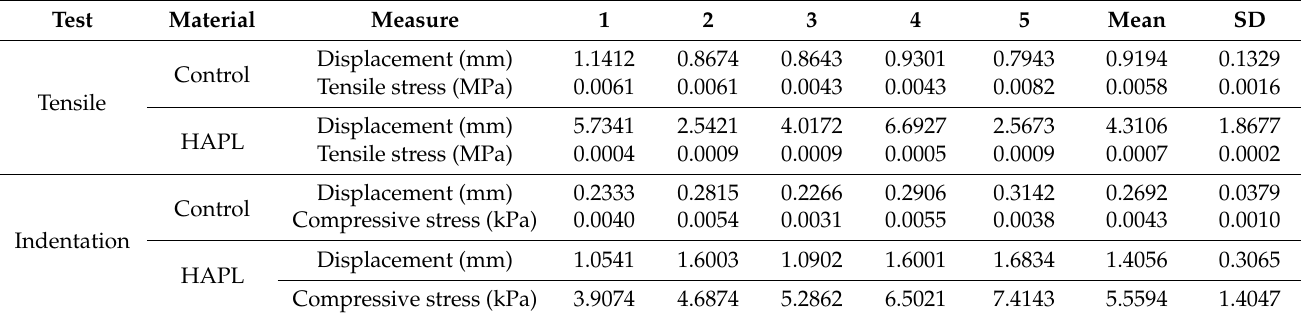
Table 2. Descriptive statistics. Tensile and indentation